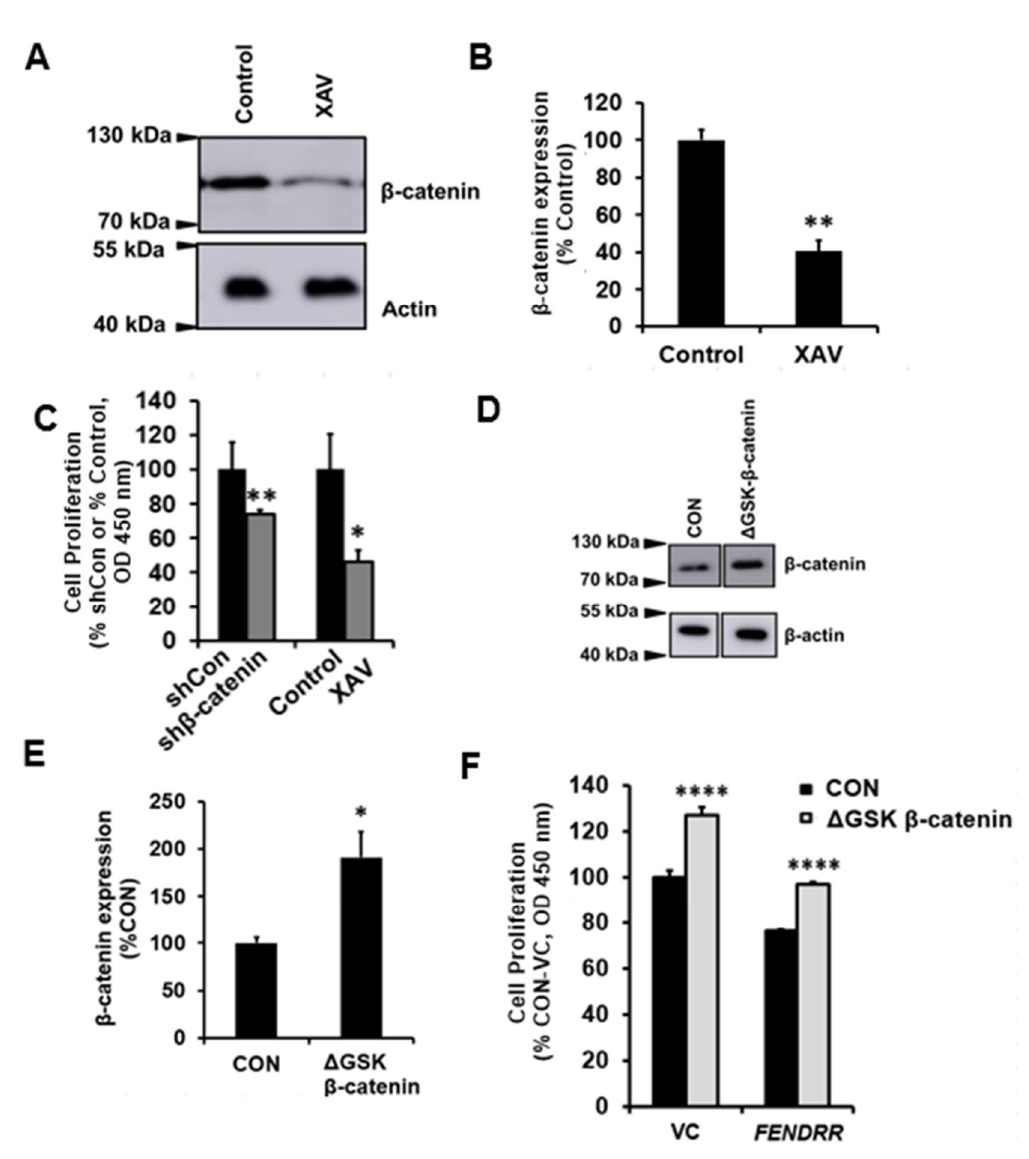
Figure 5. β -catenin contributes to fibroblast proliferation. ( A ) XVA939 (10 µ M)-mediated reduction of β -catenin protein levels in LL29 cells. The control is 0.1% DMSO. ( B ) Quantitative analysis of β -catenin protein levels in LL29 cells treated with XAV939. The results were expressed as %VC. ( C ) BrdU assay of cell proliferation in LL29 cells infected with adenovirus containing β -catenin shRNA constructs or treated with XVA939 for 6 days. The results were expressed as %shCon or %Control. ( D ) Western blot showing β -catenin levels in LL29 cells after transfection (nucleofection) of ∆ GSK- β -catenin overexpressing plasmid or its control plasmid (CON). ( E ) Quantitative analysis of β -catenin protein levels in D. The results were normalized to β -actin and expressed as %CON. ( F ) The BrdU assay was performed to determine cell proliferation in LL29 stable cells expressing vector control (VC) or FENDRR at day 6 after transfecting ∆ GSK- β -catenin overexpressing plasmid or its control plasmid (CON). The results were expressed as %VC of CON. Values represent the means ± SE. n = 3 independent experiments. * p < 0.05, ** p < 0.01, **** p < 0.0001 vs. shCon, Control or VC. Student’s t -test for ( B , C , E ). Two-way ANOVA and Tukey’s multiple comparison for ( F